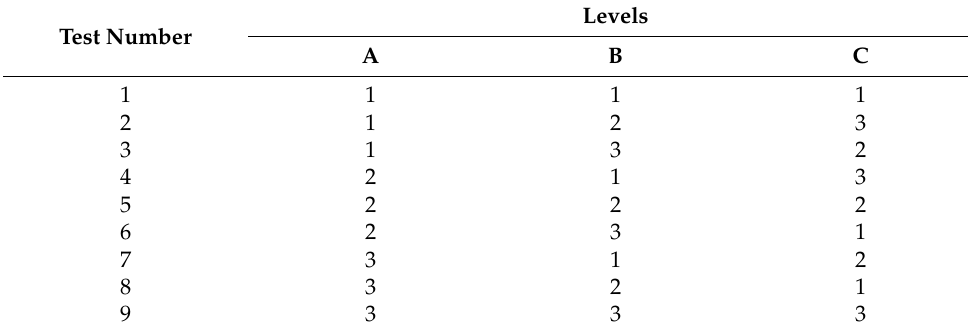
Table 3. Orthogonal Table (three factors and three levels).